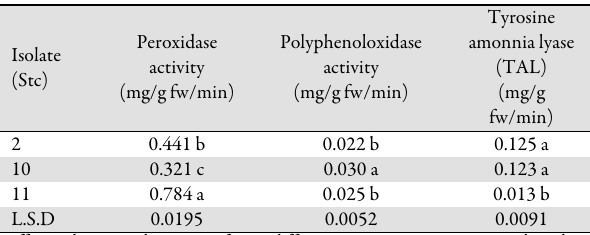
Table 4. Peroxidase , Polyphenoloxidase and Tyrosine amonnia lyase activity in three S. scabies